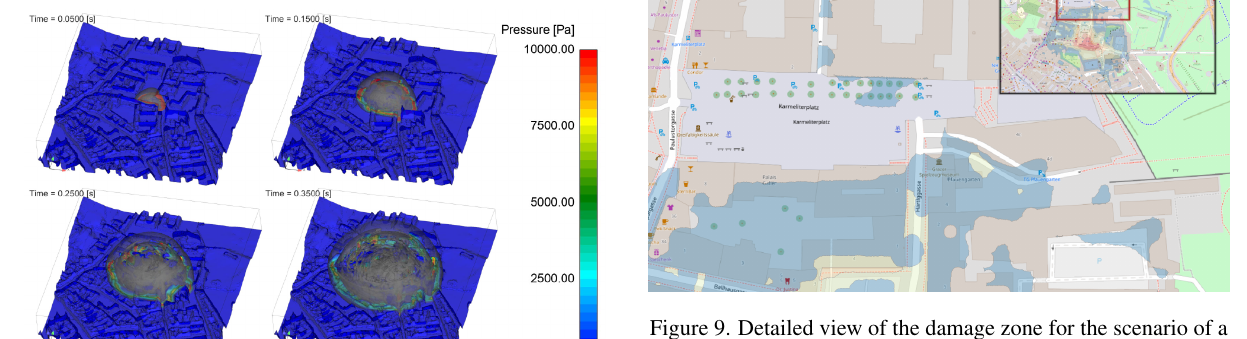
Figure 9. Detailed view of the damage zone for the scenario of a 1000 kg explosive charge. The simulation reveals disconnected areas of expected glass damage (blue areas) far away from the center of the